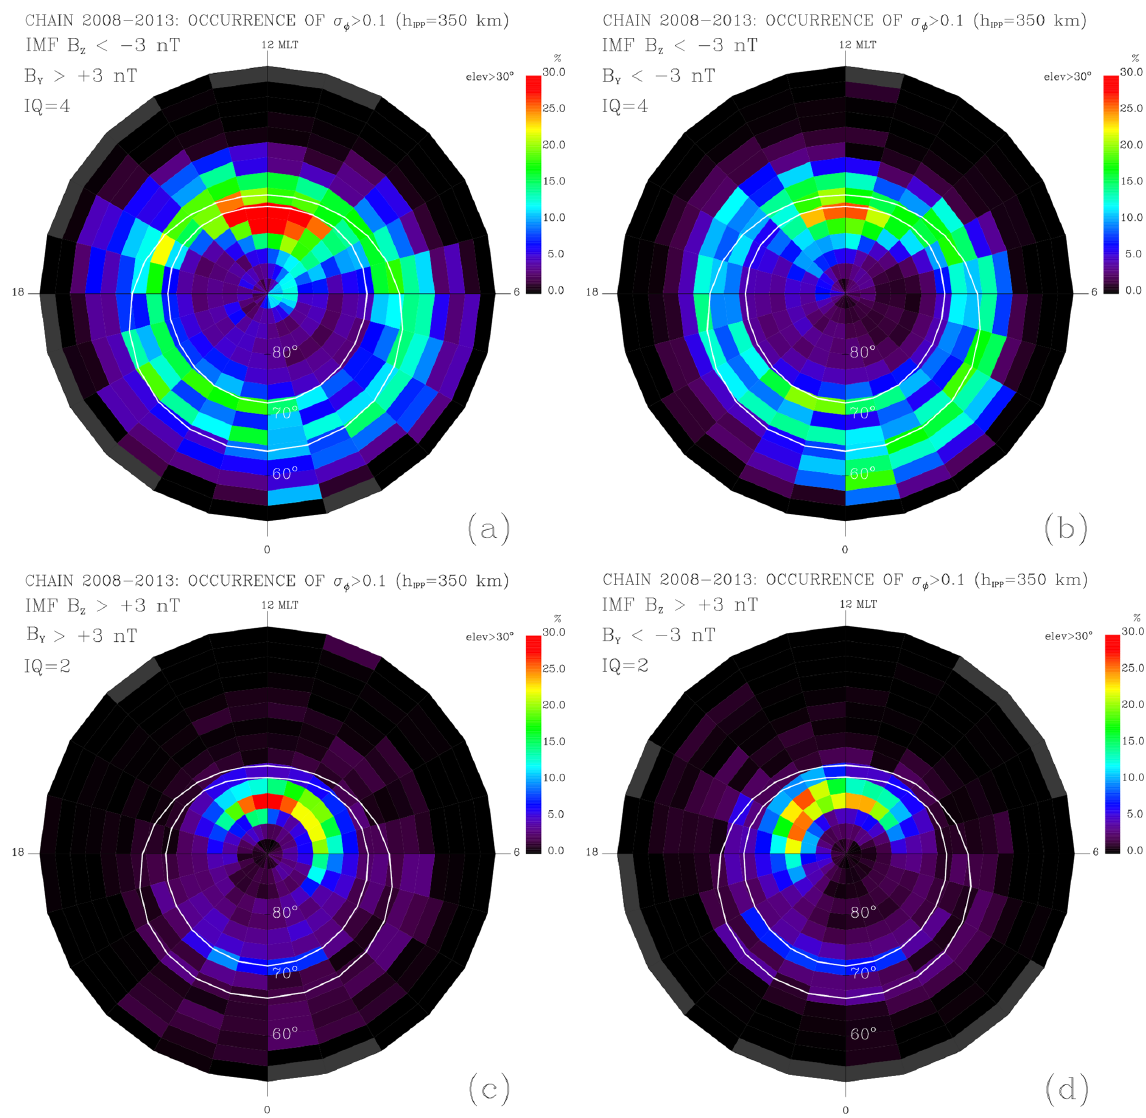
Figure 9. The 2008–2013 phase scintillation occurrence maps for strongly southward B Z < − 3nT for the cases of (a) B Y > + 3nT and (b) B Y < − 3nT, and for strongly northward B Z > + 3nT for the cases of (c) B Y > + 3nT and (d) B Y < −